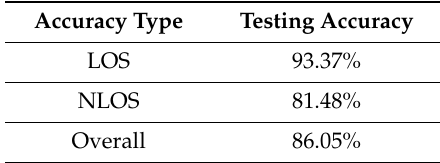
Table 2. The LOS / NLOS / Overall accuracy for the training dataset and testing dataset.